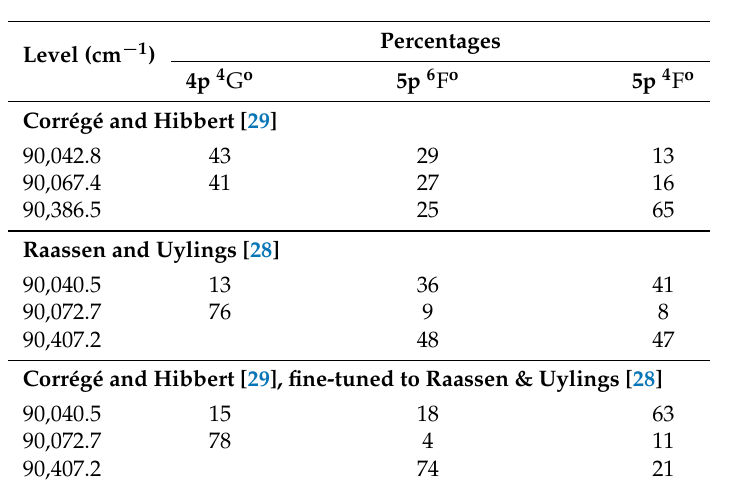
Table 5. Comparison of mixings in J = 9/2 level in Fe